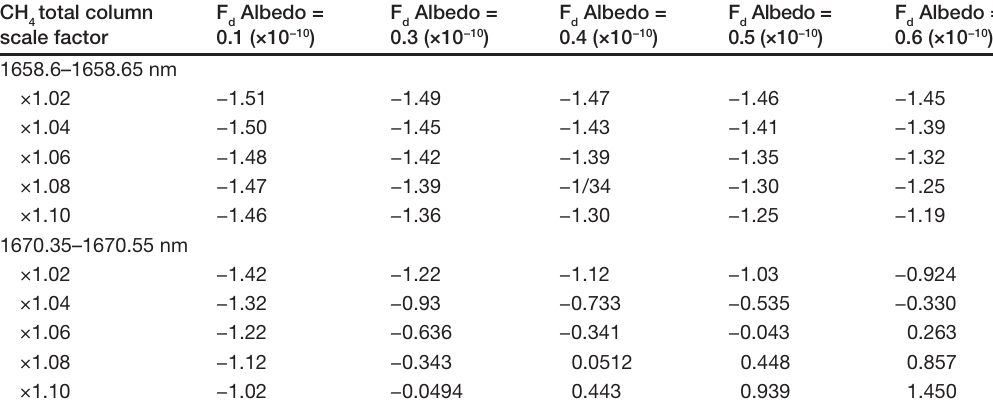
(Equation 5) values summarised for the standard conditions expressed in Table 4. Spectral average F d Table 2, assuming a global standard δ 13 C value of − 70‰. The F given the range of reflectances indicated in Table 2.